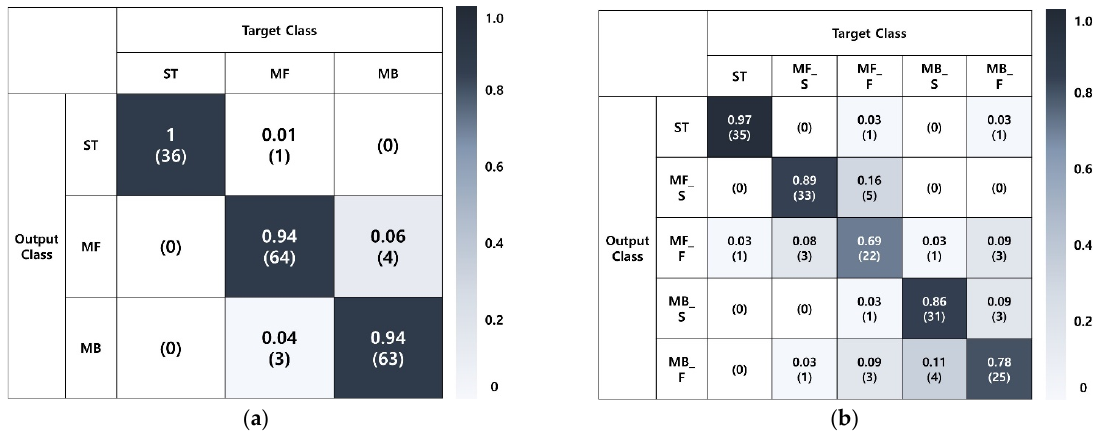
Figure 7. Confusion matrix from the indoor experiment: ( a ) 3 classes, ( b ) 5 classes. Table 3. Classification performance from the indoor experiment. Table 3. Classification performance from the indoor